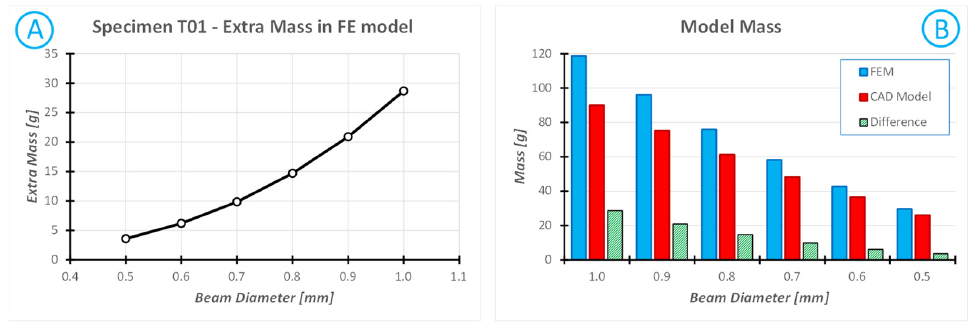
Figure 10. ( A ) Overestimated mass in FE models; ( B ) Mass comparison between FE and CAD.